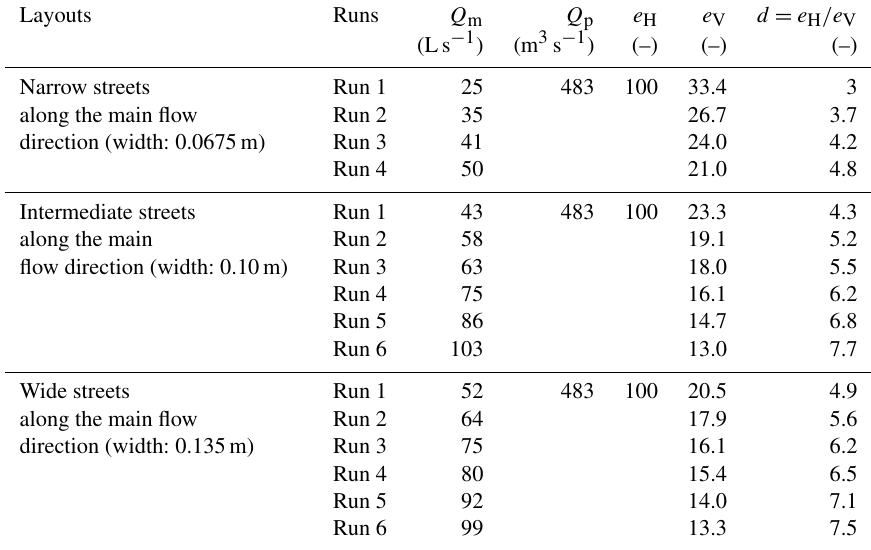
Table 3. Interpretation of the dataset of Velickovic et al. (2017) in the present reanalysis. Notations Q m and Q p refer to the total inflow discharge in the laboratory model and in the prototype,